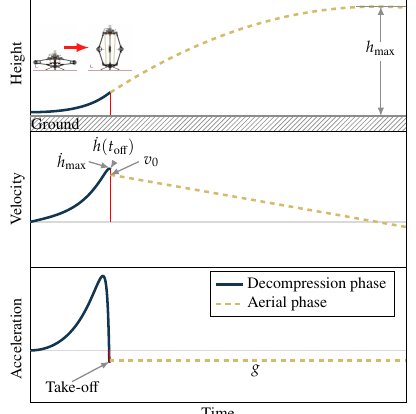
Fig.6illustratesthejumpdynamics. ThedecompressionphaseismodelledusingEqs.17andEq.18, 291 with the position data obtained from numerical integration of Eq. 16. The aerial phase is treated as a 292 ballistic trajectory in a gravity field with take-off velocity given by Eq. 21.